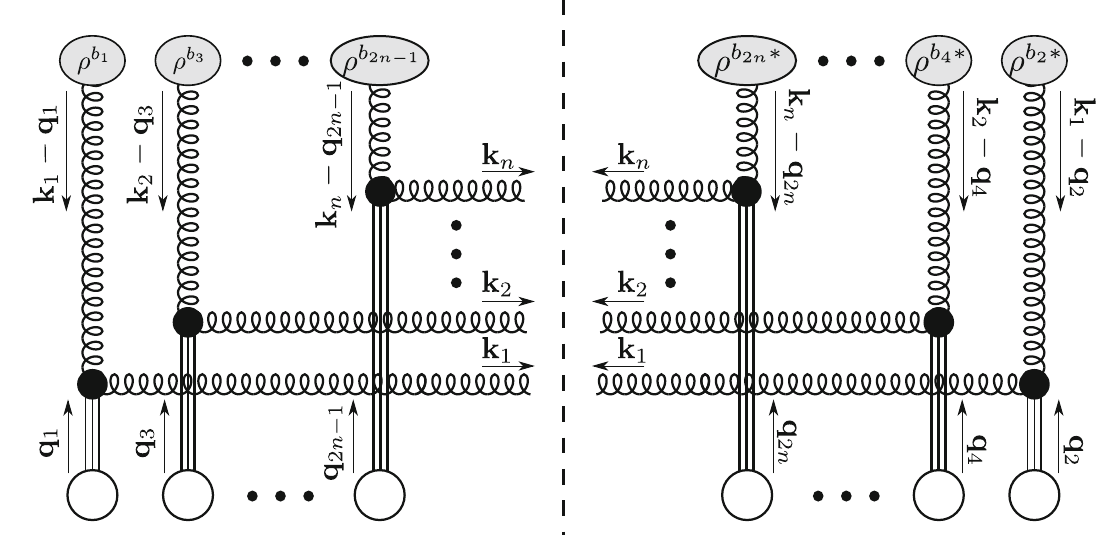
Fig. 2 Diagram showing Eq. (10) with its momentum assignments. Each group of three vertical straight lines represents the rescattering with the target, the black blobs Lipatov vertices and the vertical dashed line the cut